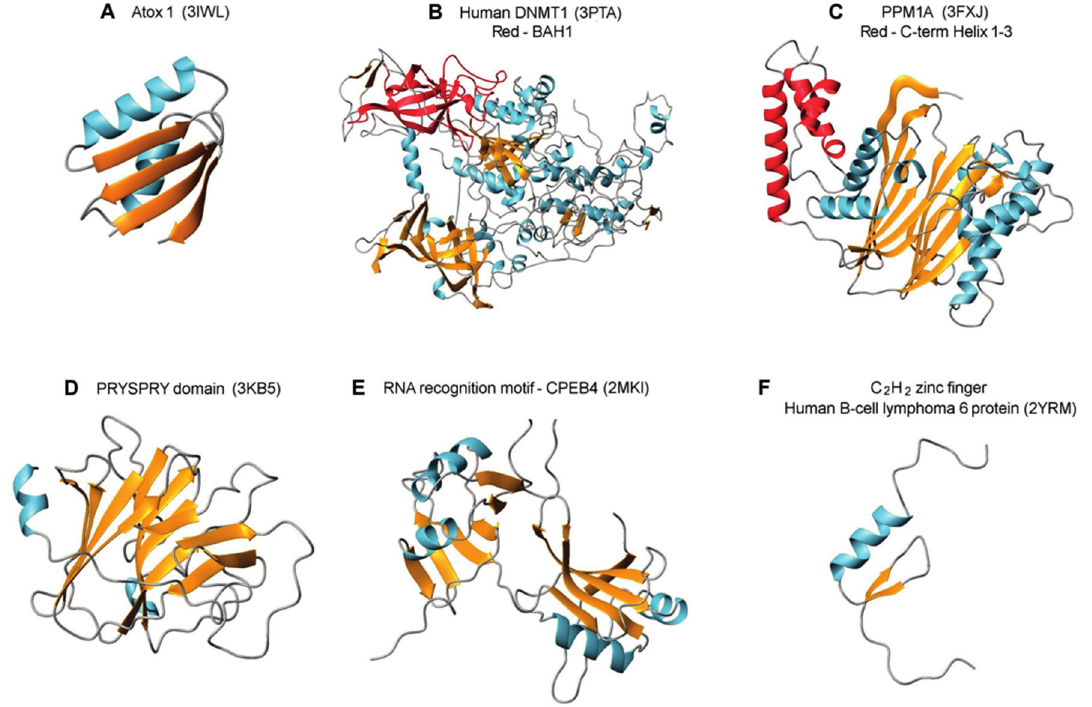
Figure 3. Structures of interacting proteins or protein domains taken from the protein data bank. ( A ) Atox1, the bait; ( B ) DNMT1 with the first BAH domain (interaction partner to Atox1) in red; ( C ) PPM1A with the three C-terminal helices (interacting with Atox1) in red. ( D ) PRYSPRY domain of TRIM72 (matching the same domain of TRIM26 with which Atox1 interacts); ( E ) The RNA recognition motif (RRM) of CPEB4; and ( F ) A zinc finger domain, as found in several of the hit